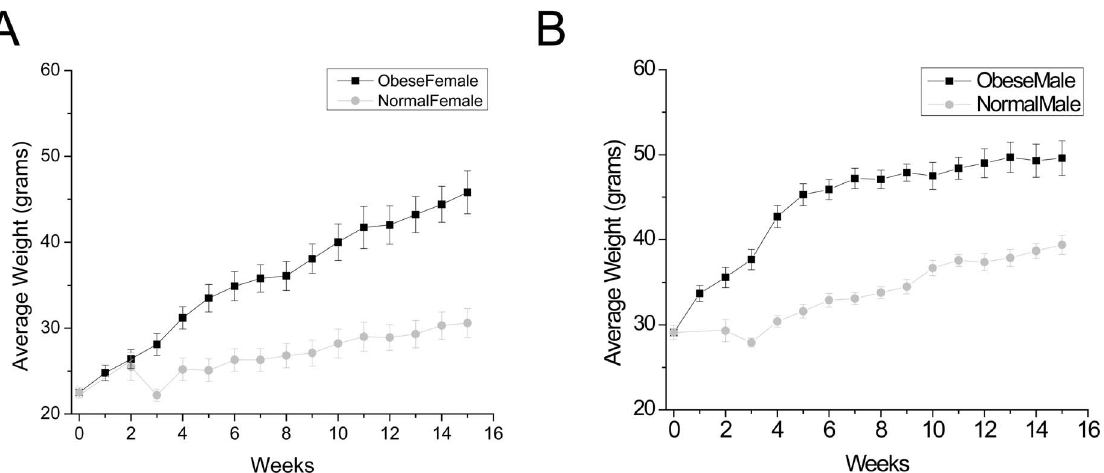
Figure 1. Mice on a high fat diet become obese compared to control mice. After two weeks, mice on the high fat diet (black line) began to show rapid weight gain compared to their littermate controls on normal diet (gray lines), n=25 for each group. Weights were recorded weekly and the average weights are reported here with standard error bars (SEM) for both female (A) and male (B). By week two, males on the high fat diet are significantly heavier than their male littermate controls (p , 0.01) and continued to be significantly heavier throughout the rest of the study. By week three, female mice on the high fat diet were significantly heavier than their female littermate controls (p , 0.01) and remained significantly heavier for the rest of the study.